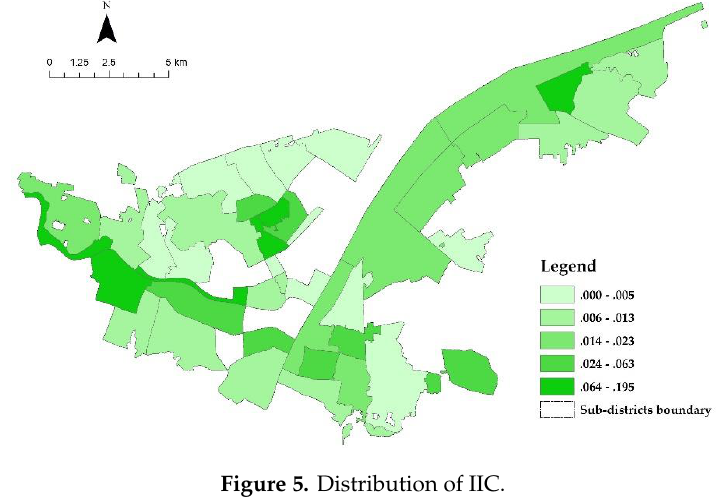
Figure 5. Distribution of IIC.